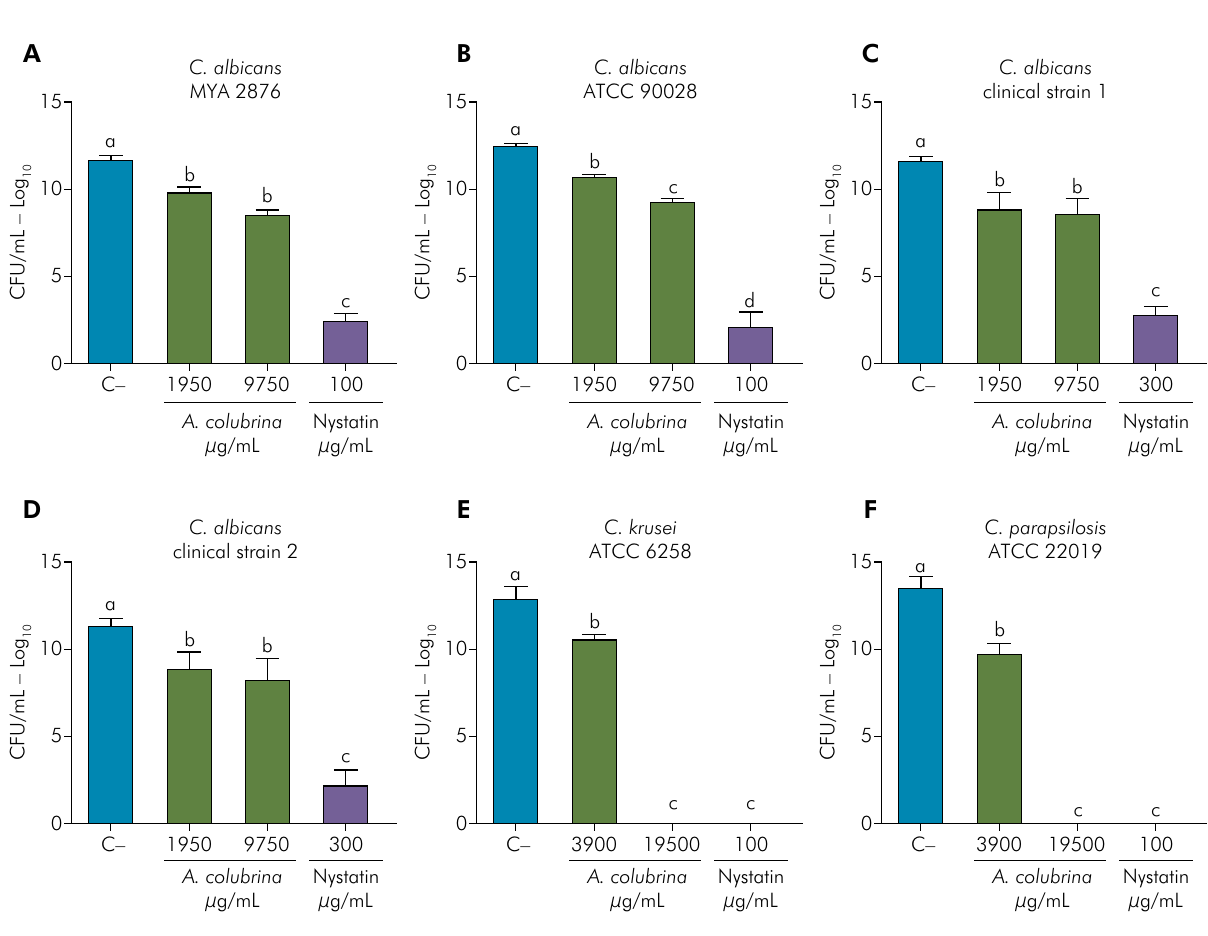
Figure 1. Antibiofilm activity of the A. colubrina extract evidencing a discrete reduction of cell viability (- Log) in C. albicans MYA 2876 (a), C. albicans ATCC 90028 (b) and C. albicans clinical strains 1 (c) and 2 (d), and reduction of cell viability in 100% for C. krusei (500x MIC) (e) and C. parapsilosis (500x MIC) (f), after treatment (p < 0.005, ANOVA with Tukey’s